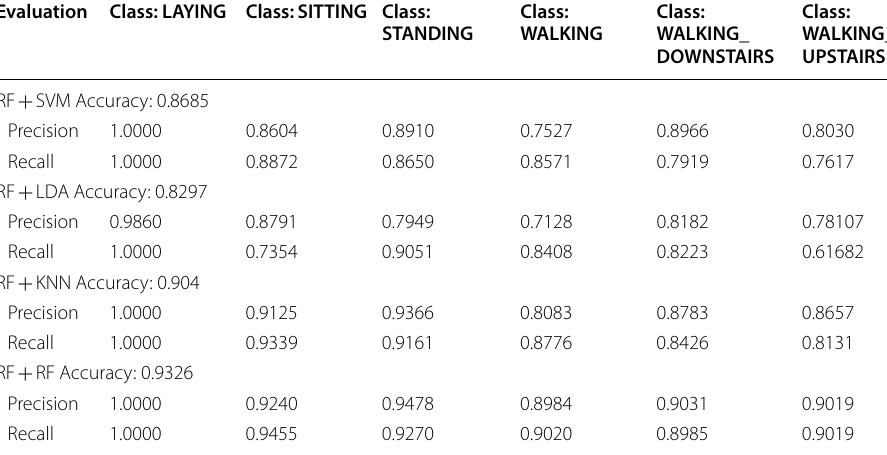
Table 13 Statistics by the class of different classifiers with human activity recognition using smartphones dataset (6